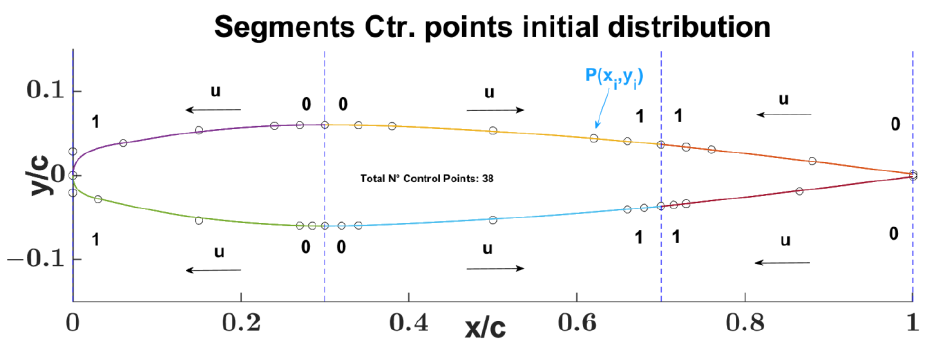
Figure 7. Example of segments CPs distributions and parametric orientation, segments are repre- sented in different colors.